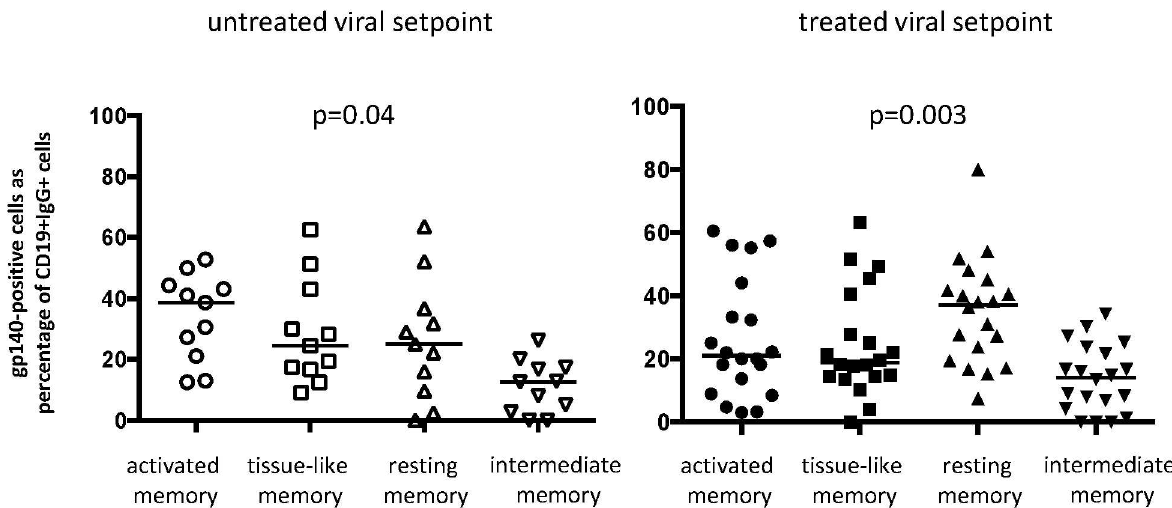
Fig 4. The phenotype of HIV gp-140-specific B cells shows a shift towards a predominance of resting memory B cell phenotype in treated patients. Scatterplots show the distribution of gp140 positive memory within IgG pos CD19 pos B cells (RM: resting memory; IM: intermediatememory; AM: activated memory; TL: tissue like memory) in untreated (left) and treated (right) patients at viral setpoint. Horizontalbars represent medianvalues. On the y-axis percentagesof gp140 pos cells expressedas percentageof IgG pos CD19 pos cells are depicted. P values show the significance level calculatedby Friedmantest. Further testing for differences betweenB cell subsets in each group was performed using Wilcoxon matched-pairs signedranks test and shows the followingsignificance levels. In summary for treated patients: RM comparedto IM p < 0.001;RM comparedto AM p = 0.16; RM comparedto TLM p = 0.18. In summary for untreated patients: RM comparedto IM p = 0.08; RM comparedto AM p = 0.4; RM comparedto TLM p =